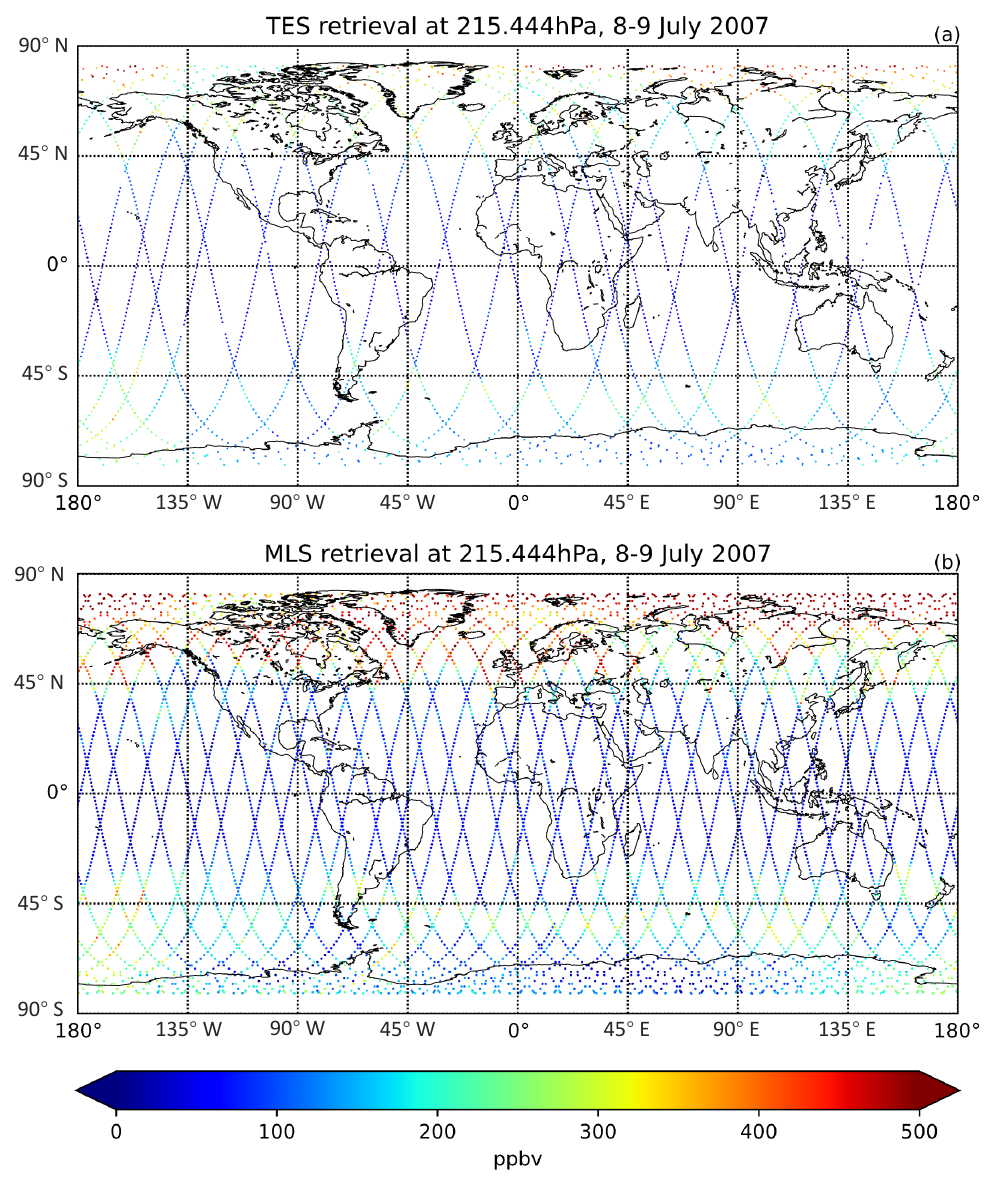
Figure 1. The orbit footprints and corresponding ozone volume mixing ratio from TES retrieval ( a ) and MLS retrieval ( b ) on 8–9 July